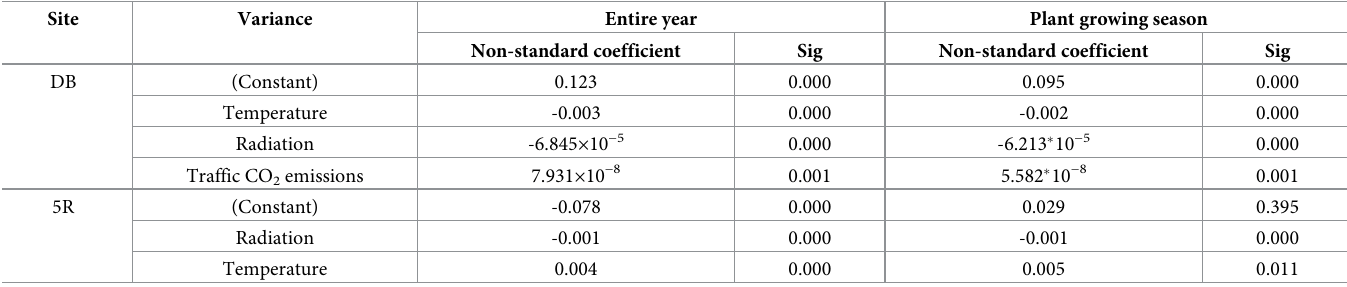
Table 2. Comparison of regression results of different urban underlying areas by the entire year and plant growing season in 2014.